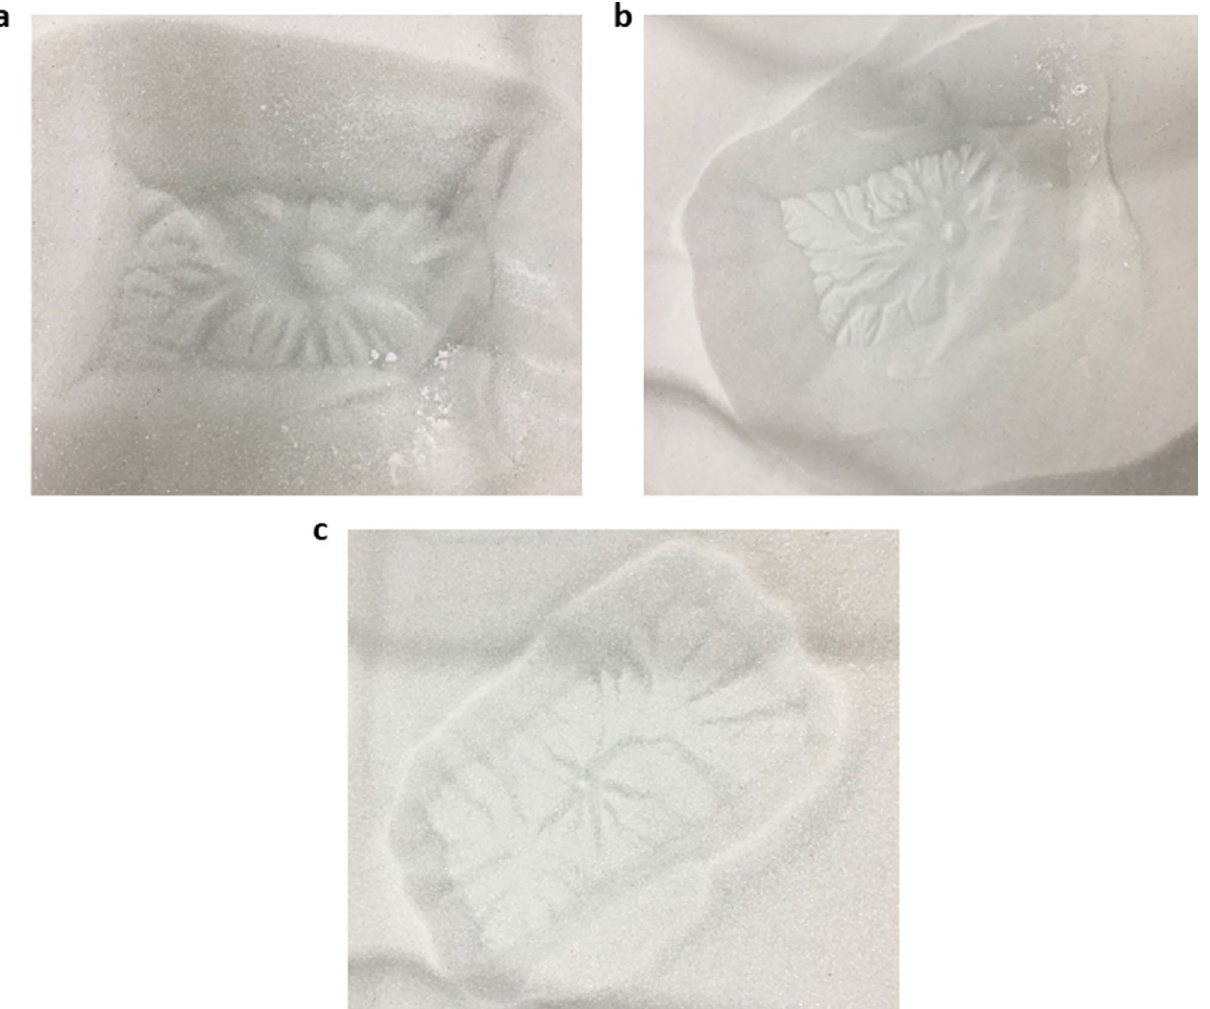
Figure 6. Area covered by araneiform with grain size. ( a ) Shows araneiform formed with a 5 mm vent on 160–212 µ m grains. ( b ) Shows araneiform formed with a 5 mm vent on 150–250 µ m grains. ( c ) Shows araneiform formed with a 5 mm vent on 425–600 µ m grains. The area the araneiforms cover appears to increase with smaller grain